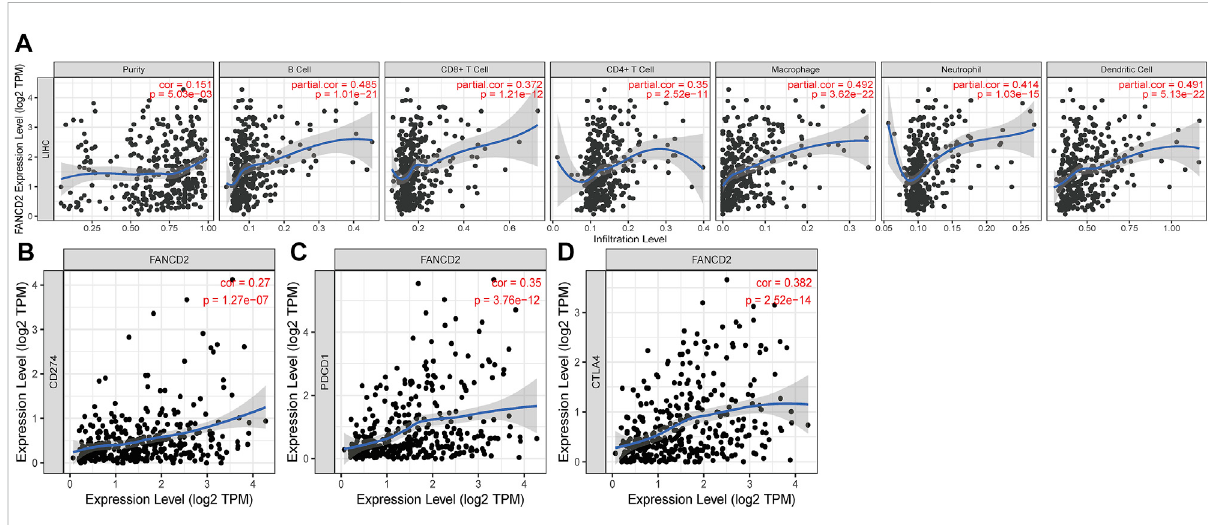
FIGURE 9 Correlation of FANCD2 expression with immune in fi ltration level (A) and immune checkpoints (B – D) in HCC.